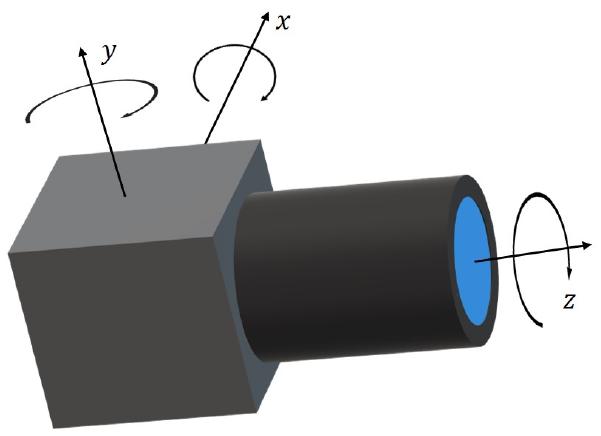
Figure 5. Camera motions during measurement.